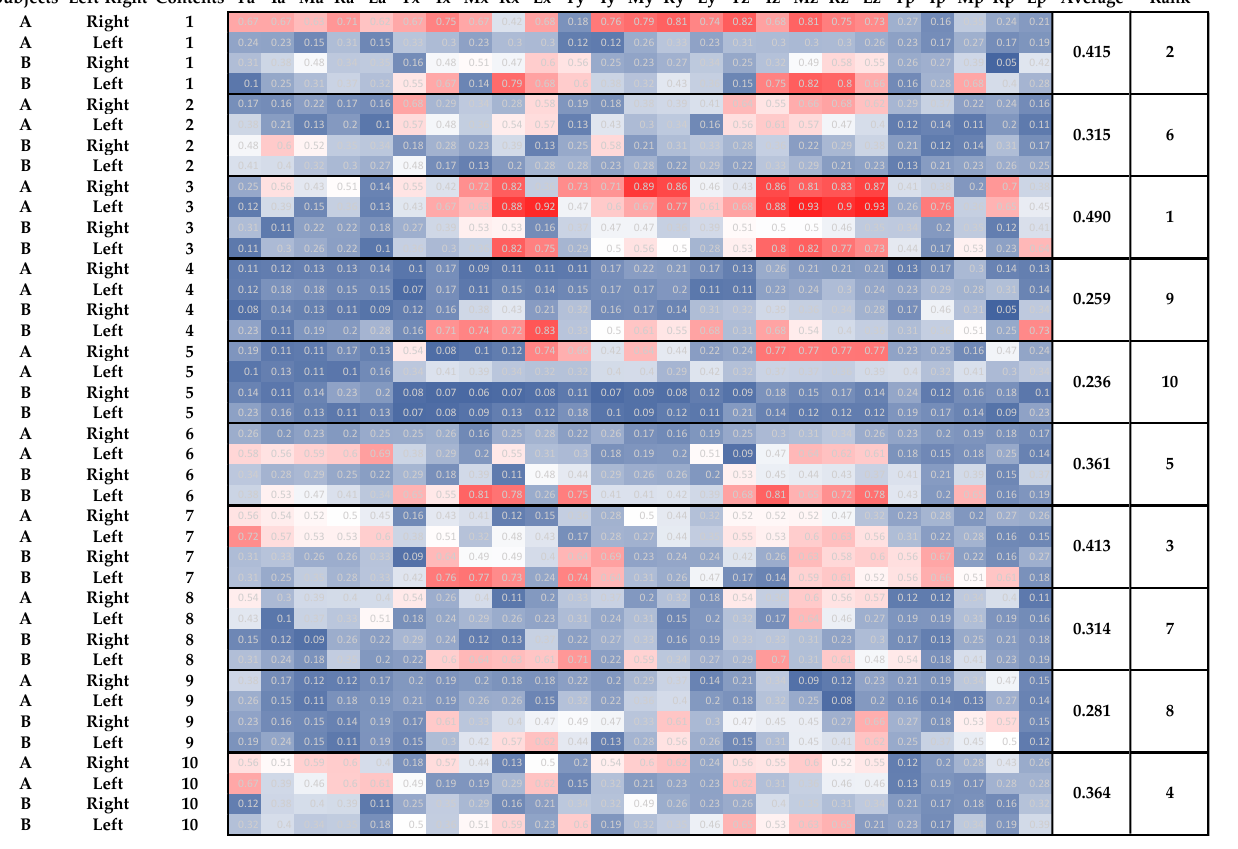
Figure 6. Frequency analysis result: The value of the highest power frequency divided by the total power and the average value and its ranking by